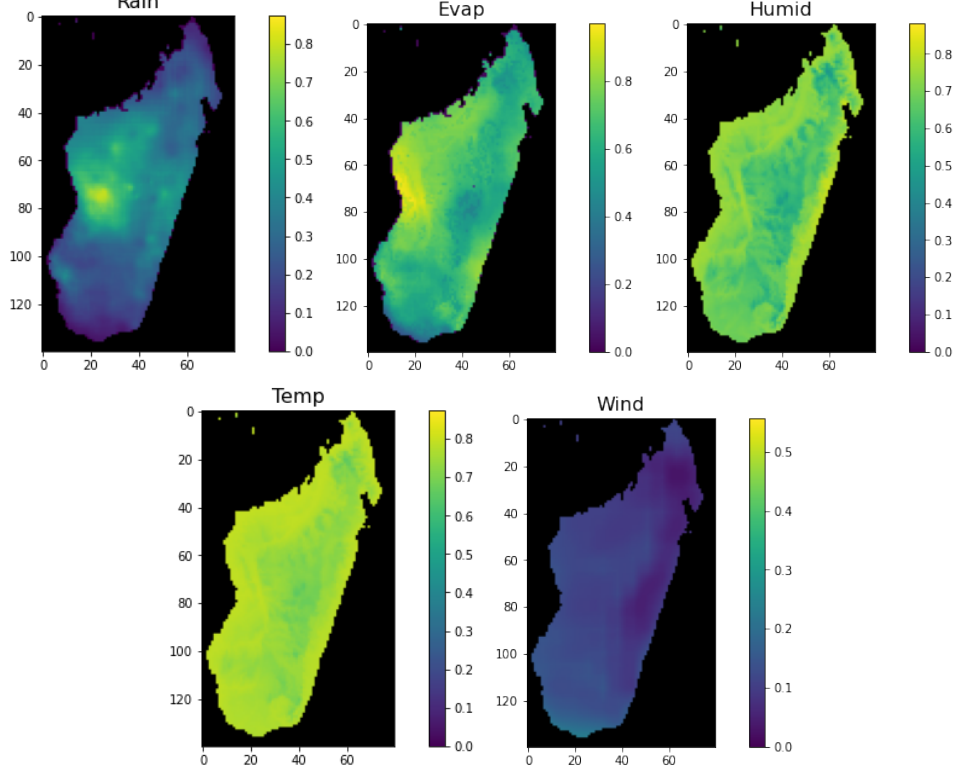
Figure 2. Images showing normalized values of five climatic parameters of Madagascar used in this study (left to right): rainfall (Rain), evaporation (Evap), humidity (Humid), temperature (Temp), and